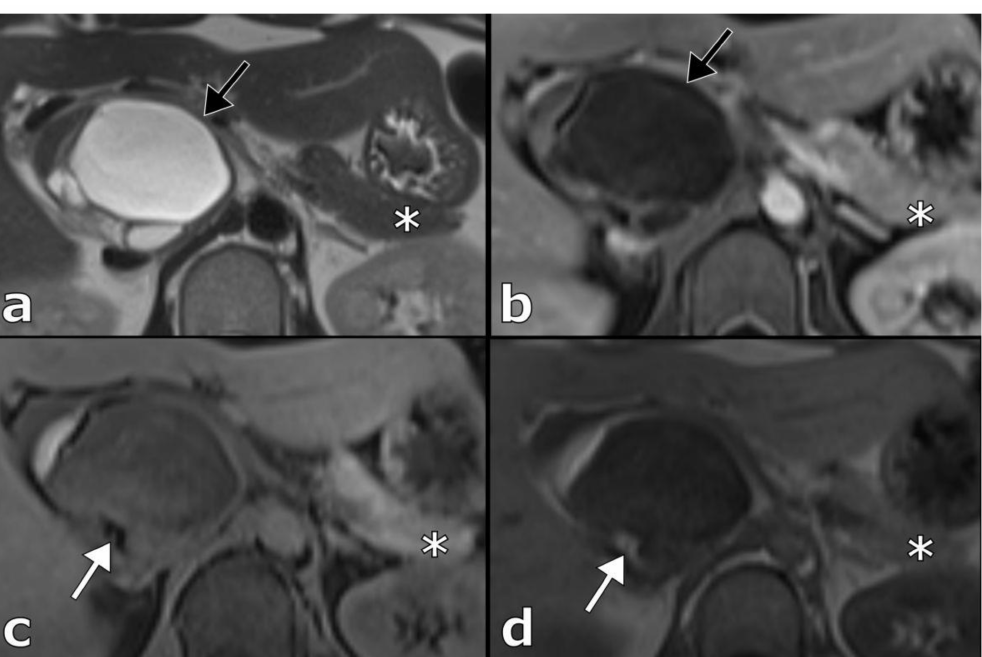
Figure 2. Contrast enhanced MRI of the abdomen. T2 weighted images ( a ) demonstrate the predomi- nantly cystic component of the tumor with thin wall (black arrow), that has no apparent enhancement on post-contrast imaging ( b ). T1-weighted imaging ( c ) depicts an area of the high-signal intensity in the tumor (white arrow) with the corresponding signal-drop on the T1 fat saturated sequence ( d ), indicating the presence of macroscopic fat tissue in the tumor. Notice the absence of the dilation of the pancreatic duct (asterisk, all sequences).